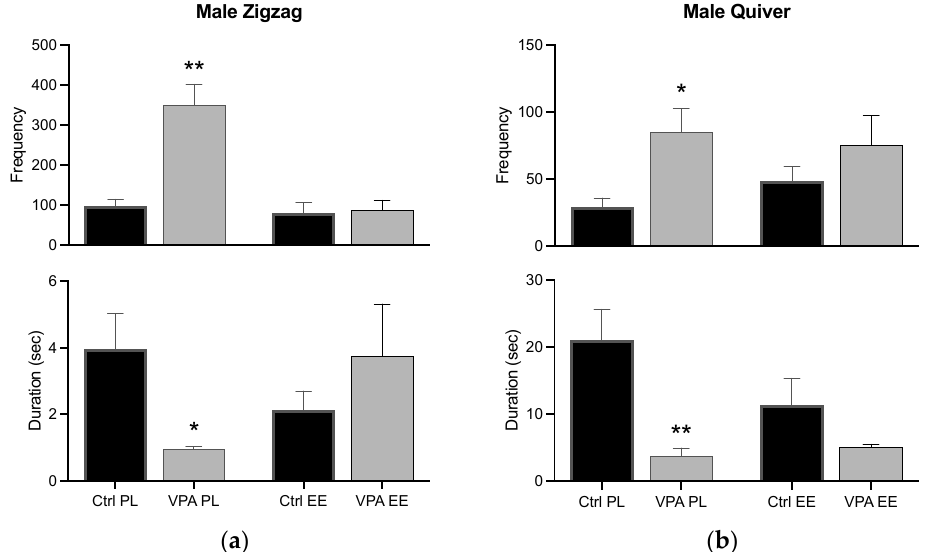
Figure 8. Zigzag and quiver behaviors in males. The graph shows how many times the male executed the zigzag ( a ) and quiver ( b ) behaviors (frequency), and how long he displayed such behaviors for (duration). Data show the mean ± SEM. * = p < 0.05; ** = p < 0.01.